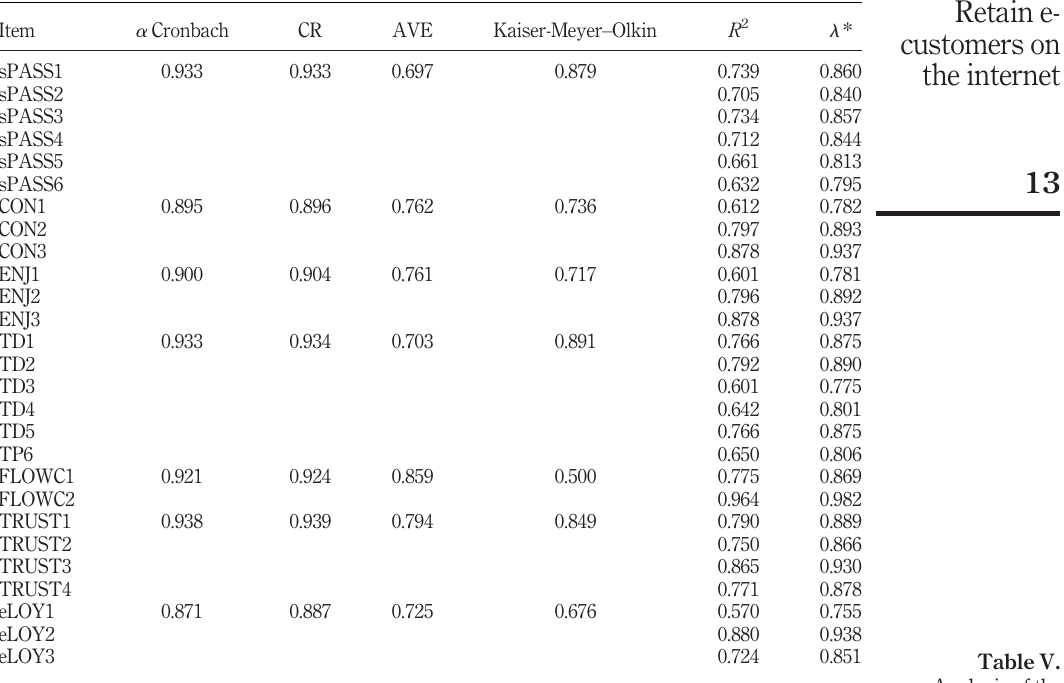
Analysis of the reliability and validity of the SOR